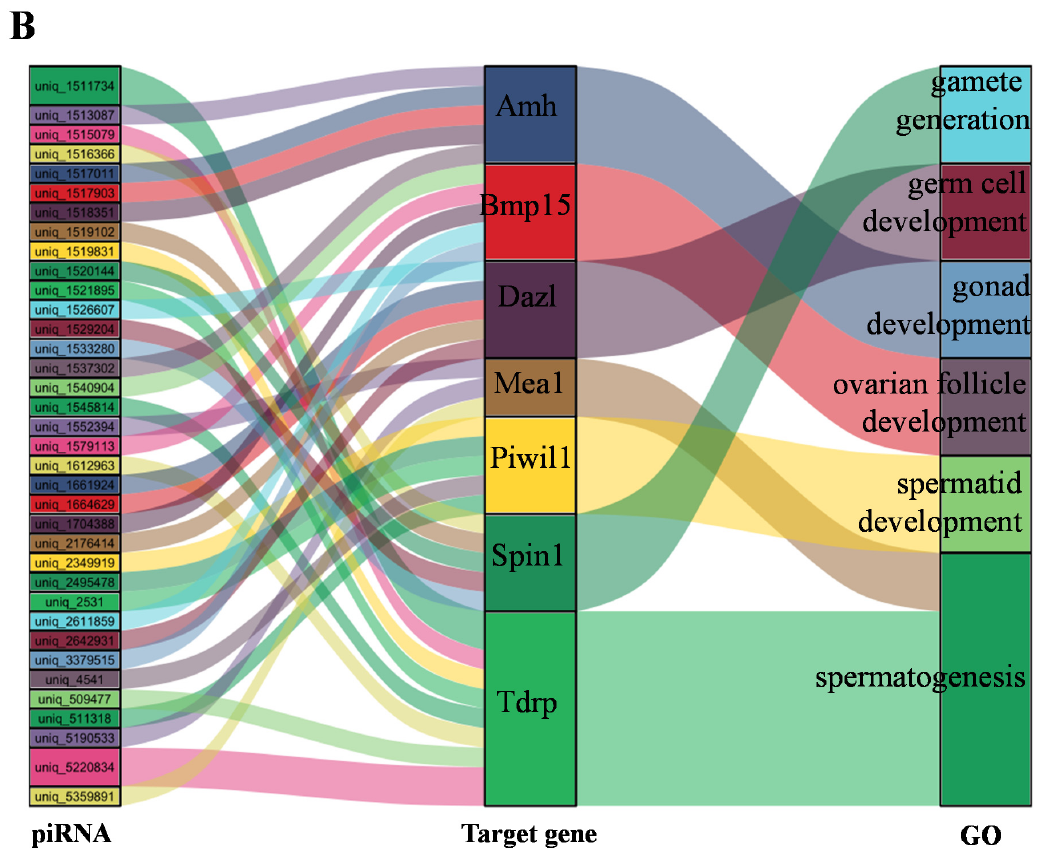
Figure 3. Putative functions and pathways of differentially expressed piRNAs. ( A ) GO analysis of the target genes of differentially expressed piRNAs. Only the top 20 GO terms are presented. Bubble color indicates the p value, and bubble size indicates the number of enriched genes. (B) Sankey diagram showing the relationship between differentially expressed piRNAs, target genes, and sex-related functions.